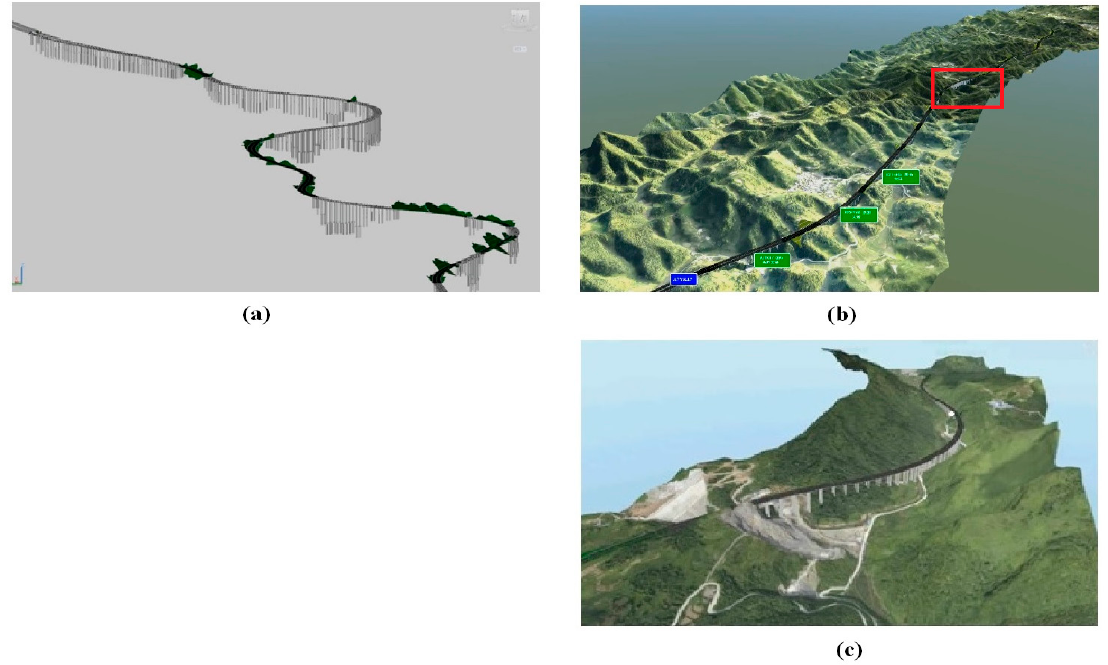
Figure 17. ( a ) The project in BIM environment; ( b ) the overview of the project in the integrated system; ( c ) the enlarged section (the squared part in ( b )) of the project in the integrated system.